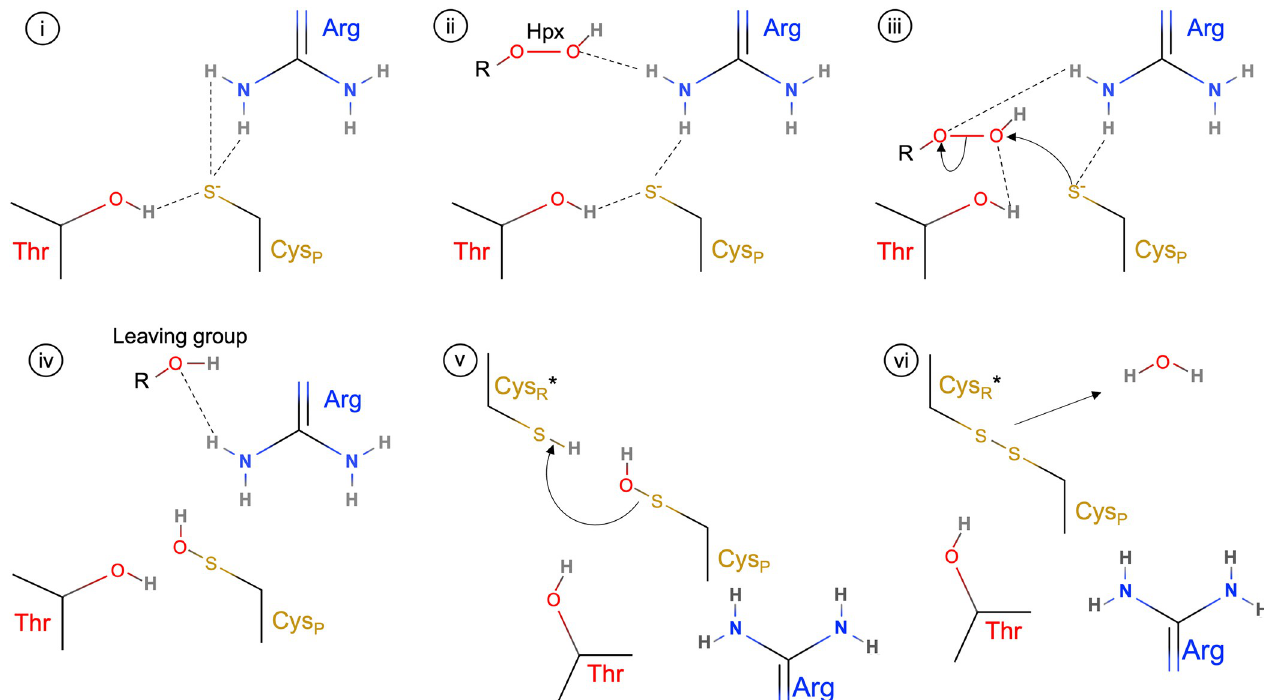
Fig 1. Molecular interactions and peroxide decomposition reactions of 2-Cys Prx. The thiolate nucleophilicity of peroxidatic cysteine (Cys P ) is increased by hydrogen bonds with the catalytic triad Arg and Thr residues (i) . The hydroperoxide (Hpx) is trapped by the Arg hydrogen bond which is able to target the Hpx to the Prx active site (ii) . The shift of the Arg and Thr hydrogen bonds from the Cys P thiolate to the substrate stabilizes the Hpx and increase the thiolate reactivity enabling the S N 2 mechanism (iii) . After the catalytic reaction, the Cys P is oxidized to cysteine sulfenic acid (Cys P -SOH) and the release of the leaving group (R-OH, meaning a water molecule in the case of hydrogen peroxide, or the alcohol derivative, in the case of organic hydroperoxides) is assisted by polar interaction with Arg (iv ). The cysteine sulfenic acid formation triggers structural changes which allow the condensation among Cys P -SOH with Cys R -SH (v) resulting in the disulfide formation and concomitant release of a water molecule (vi) . The asterisk ( � ) in Cys R , denotes the adjacent subunit of the homodimer.